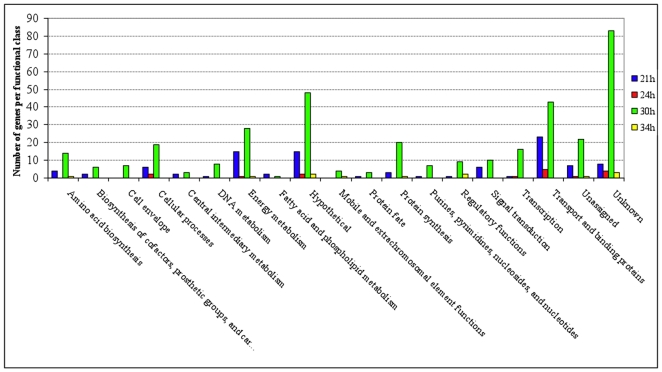
Number of S. mutans genes differentially expressed in suc+st-biofilms (vs. suc-biofilms) at various time-points organized by functional class.Suc+st-biofilms were formed in 0.5% sucrose+1% starch; suc-biofilms were formed in 1% sucrose. Gene annotations are based on information provided by the Los Alamos National Laboratory (www.oralgen.lanl.gov) or by published literature available at the same Website.